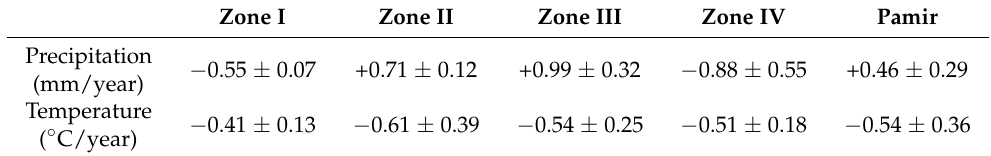
Table 3. Interannual variations in precipitation and temperature in the Pamir from 2018 to 2021.